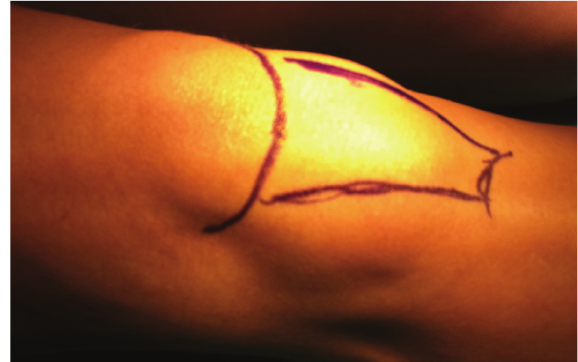
Figure 1: Mass observed in the infrapatellar region.